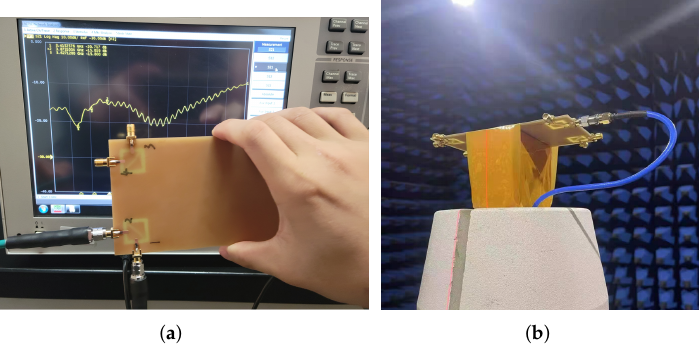
Figure 8. Photograph of ( a ) test use of the vector network measurement analyzer. ( b ) Test in the anechoic chamber.